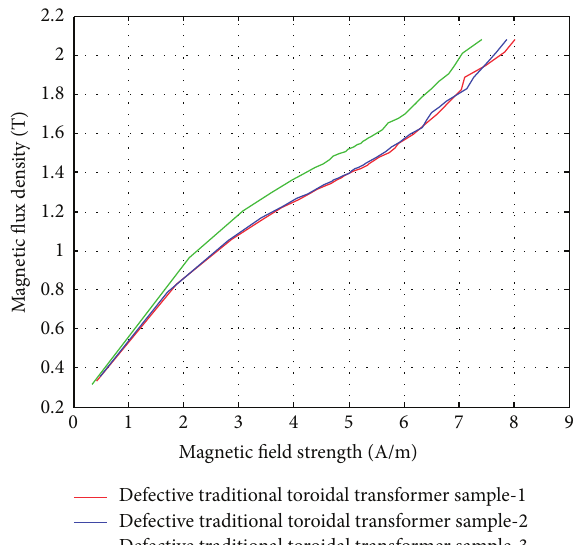
Figure 2: The iron loss curves of the three traditional toroidal transformer samples. The specifications are the same, but the iron loss curves are obviously different (the sample windings are found to be defective).